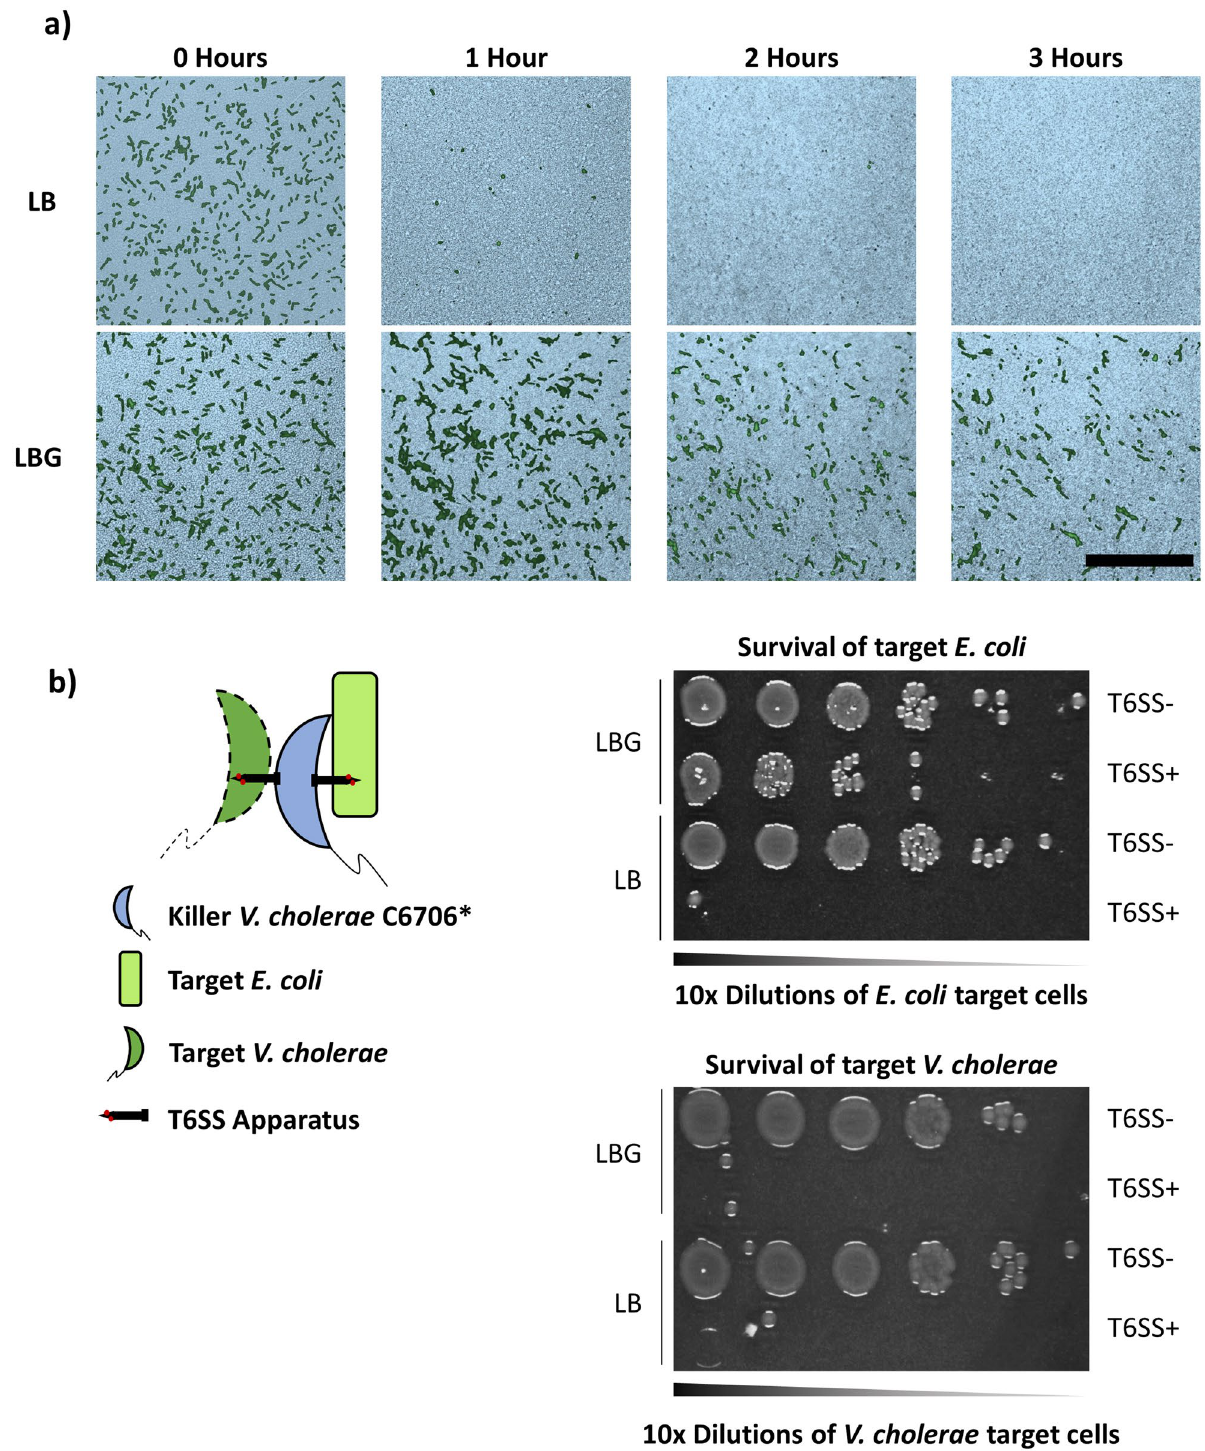
Figure 3. Individual E. coli MG1655 cells are protected against V. cholerae T6SS attacks but do not impair T6SS killing. ( a ) Fluorescently labeled green E. coli MG1655 cells were densely co-cultured with unlabeled V. cholerae C6706* on LB (top panels) or LBG (bottom panels) and the same frame was imaged for three hours using confocal microscopy. The pseudocolor images depict the progression of T6SS killing at different time points, showing brightfield microscopy images (bright blue) of the dense biofilm overlaid with the fluorescence signal of E. coli cells projected on a plane parallel to the agar substrate. Scale bar is 50 µm. ( b ) Killer V. cholerae C6706* or C6706* T6SS- was co-cultured with both E. coli MG1655 and susceptible V. cholerae target cells, and then diluted and plated as described in the “Methods”